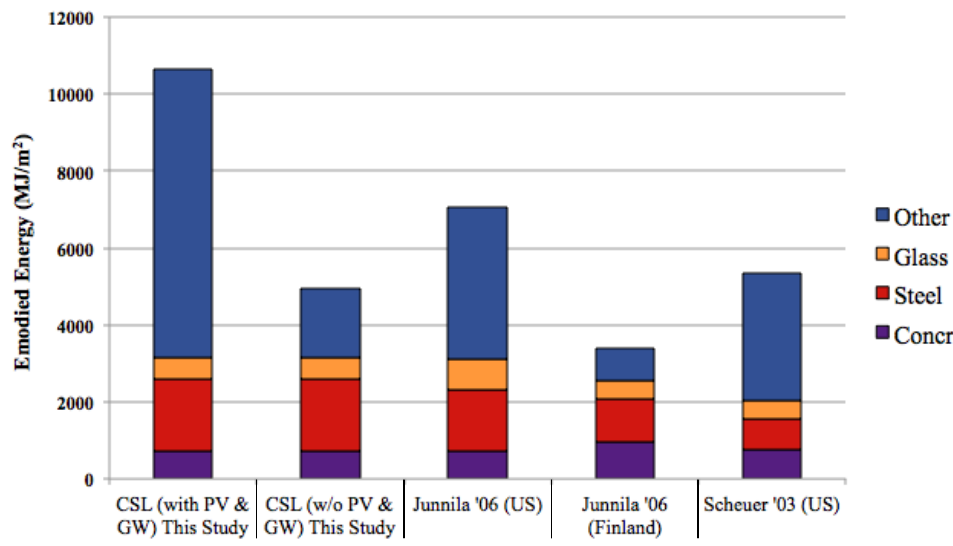
Figure 5. Embodied energy comparison between the Net-Zero Energy CSL building and published LCA building studies; PV = Photovoltaic & Inverters; GW = Geothermal Wells; Note: Junnila ’03 and Kofoworola ’07 did not report on embodied